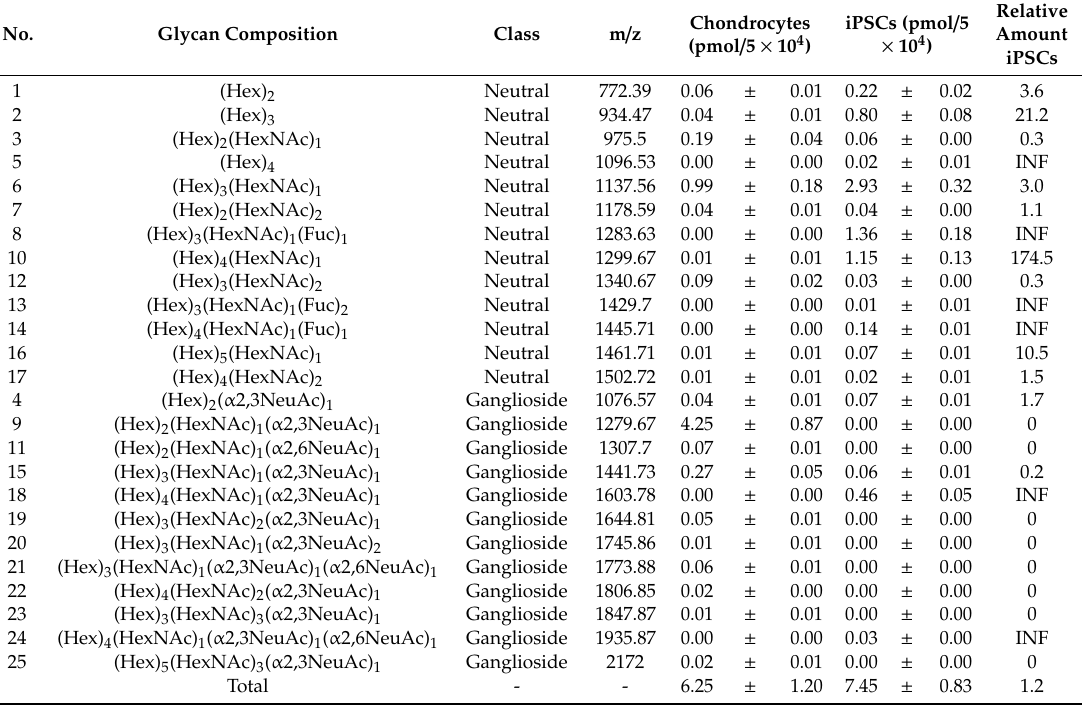
Table 1. The glycan composition and quantitation of GSL-glycans in both chondrocytes and iPSCs.